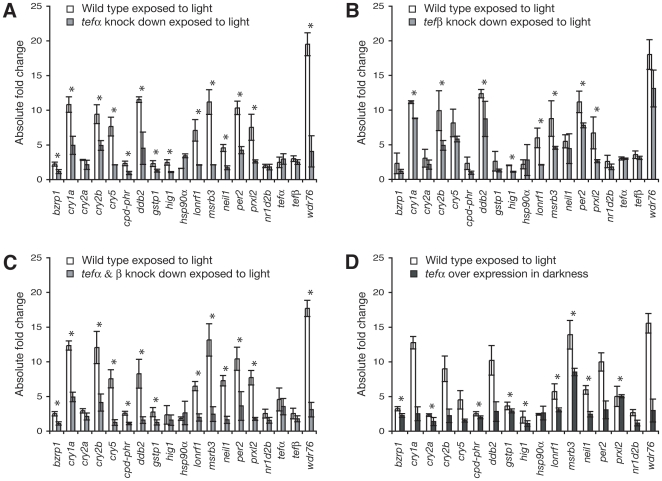
Tef regulates light-induced transcription.(A) Transcript level analysis by qPCR after 9 hours of light exposure in morpholino microinjected tefα knock down embryos (grey bars) compared to untreated embryos (white bars). Asterisks indicate significant difference in expression level. (B) Experiment as in A for morpholino-mediated knock down of tefβ in light exposed embryos. Demonstrating the reduced effect of tefβ knock down on the levels of most light-induced transcripts when compared with tefα knock down. (C) Morpholino-mediated double knock down of tefα and tefβ in light exposed embryos matches the tefα knock down result. (D) Embryos microinjected with tefα mRNA and directly transferred to DD. tef over expression results in elevated transcript levels when compared to untreated embryos maintained in DD. Fold changes were normalized with DD transcript levels, thus the knock down, over expression, and wild type light exposed transcript levels are compared to the wild type expression level in DD, which is set at zero on the Y-axis within each bar. Differences between samples were corrected with β-actin mRNA levels. These data clearly demonstrate that Tef mediates the regulation of light-induced transcription.